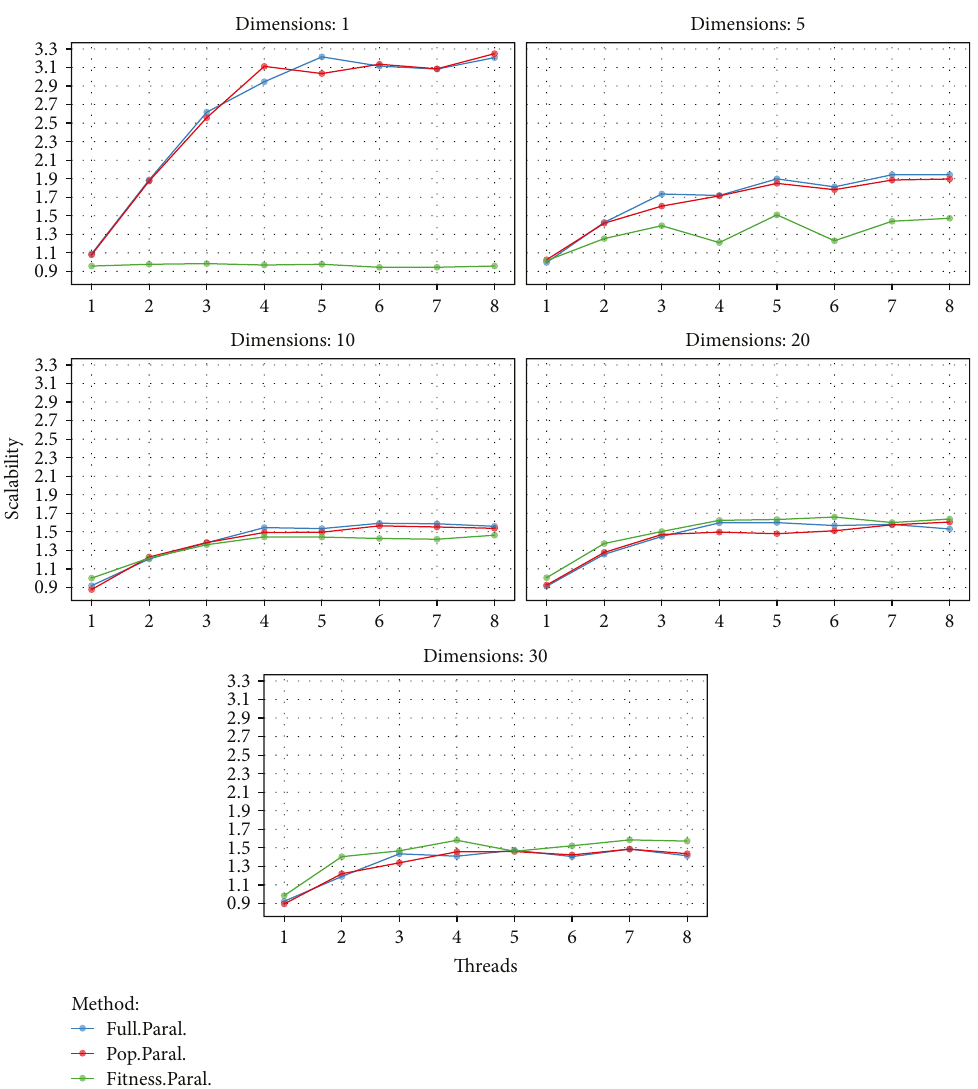
Figure 6: Speed-up plots for a population size of 100 , with individuals of 1, 5, 10, 20 , and 30 dimensions and using from 1 to 8